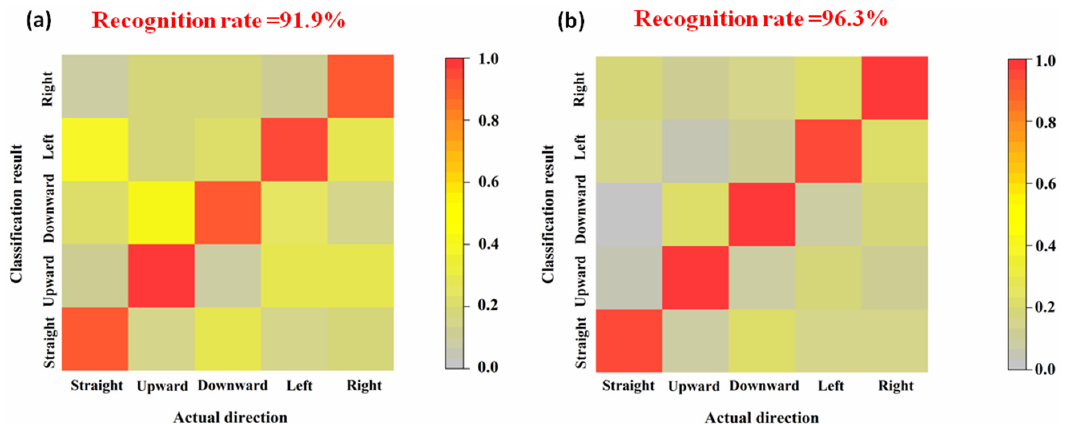
Figure 7. Recognition accuracy of eye movement states. ( a ) Ag/AgCl electrode. ( b ) Flexible hydrogel biosensor.